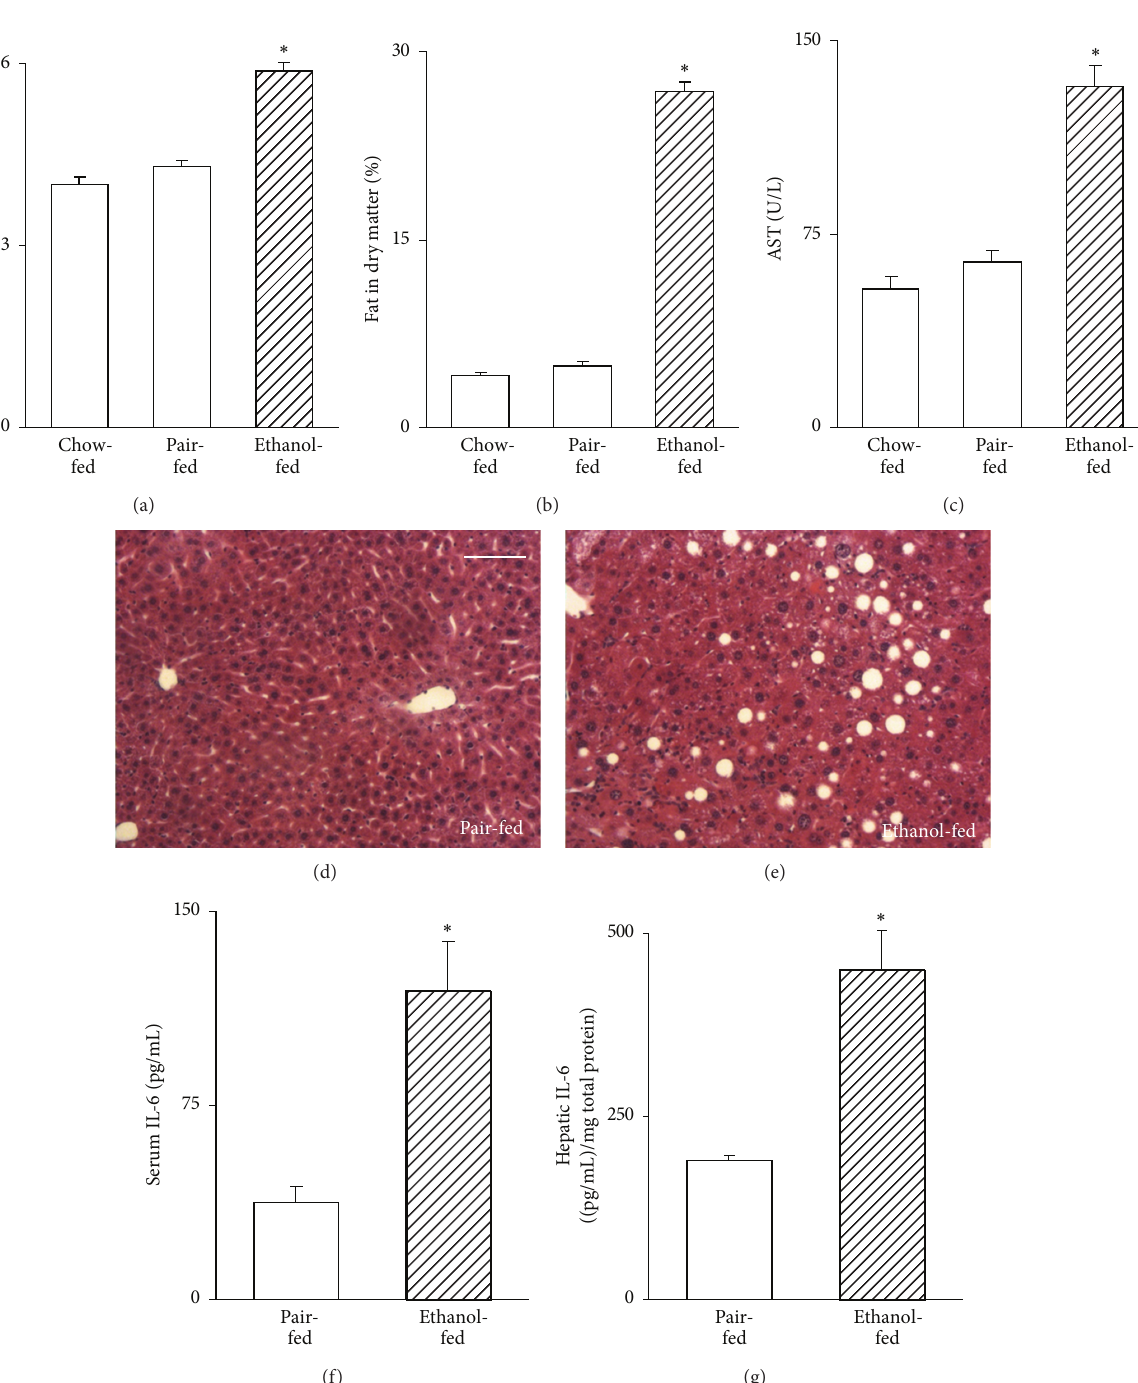
Figure 2: EtOH-containing liquid diet affects fatty liver and increased proinflammatory IL-6 release 4 weeks after feeding mice an ethanol (EtOH-fed) or control (pair-fed) Lieber DeCarli diet; blood samples and livers were harvested as described in Section 2. Chow-fed animals served as internal controls for the pair feeding approach. Data are given as mean ± SEM. 𝑃 < 0.05 versus all. In (a), liver body ratio from pair-fed mice is presented. Hepatic dry fat content was quantified by means of Soxhlet technique as described in Section 2. section (b). Serum aspartate aminotransferase levels were measured (c). Representative photomicrographs of HE stained liver sections from (d) pair- and (e) ethanol-fed mice are presented. Bar equals 100 𝜇 m. In (f), systemic levels of IL-6, and in (g), hepatic IL-6 proteins are shown. ∗ 𝑃 < 0.05 versus pair-fed